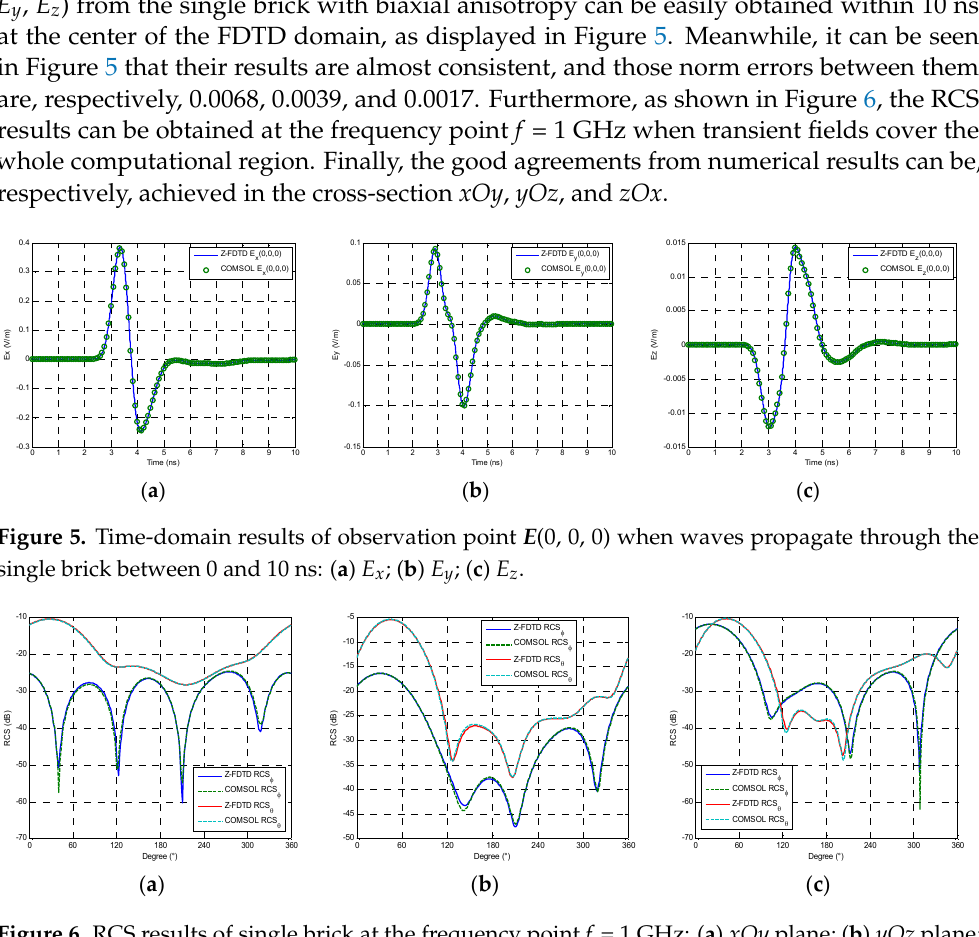
Figure 4. Three ‐ dimensional single brick with biaxial anisotropy, where E (0,0,0) is denoted as the observation point in time domain. The CFS ‐ PML proposed in Section 2 is adopted to truncate the 3D Z ‐ FDTD domain, which is 69 × 69 × 69 in the specific grids and Δ x = Δ y = Δ z = 0.005 m in the spatial cell. Moreover, the parameters of plane waves are set as E θ = 1, E φ = 0, θ inc = 45°, φ inc = 30°. By